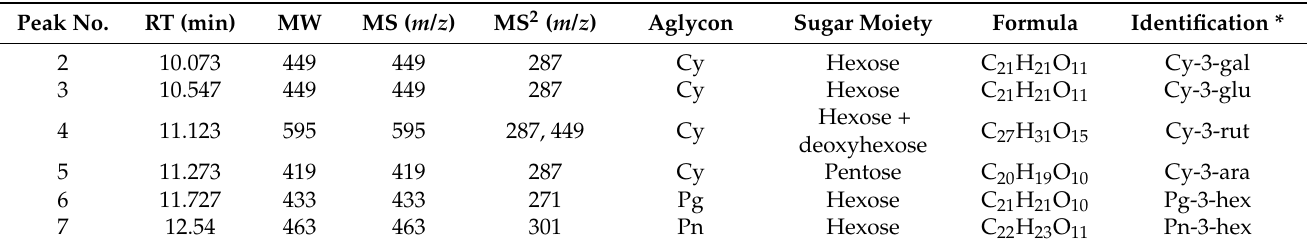
Table 1. Identification of anthocyanins in five blueberry extracts and peak numbers as in Figure 1A(b). Peak